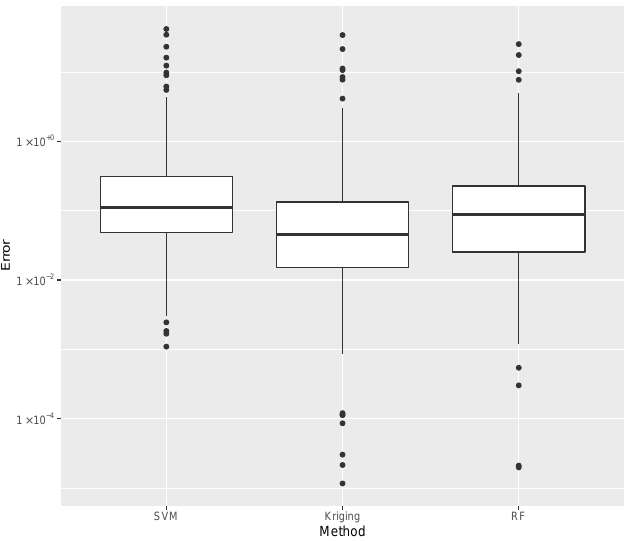
Figure 16. Comparison of P critical error dispersion considering the best SVM, Kriging, and Random Forest